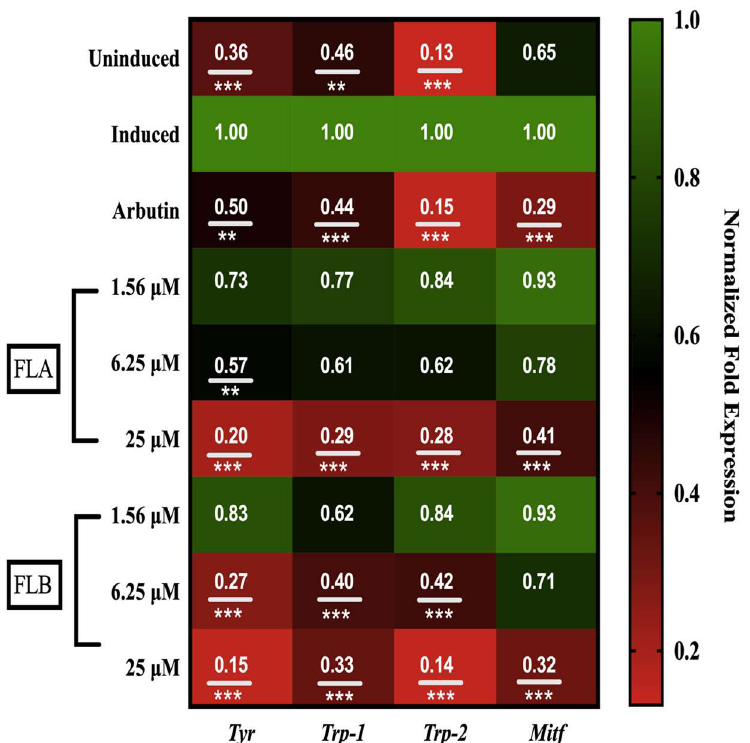
Figure 4. Effect of chalcone derivatives on the mRNA expression of melanogenic-related genes: tyrosinase ( Tyr ), tyrosine-related protein 1 and 2 ( Trp-1 and -2 ) and microphthalmia-associated transcription factor ( Mitf ). B16/F10 cells (2 × 10 5 cells/well) were treated with 10 nM of α-MSH for 72